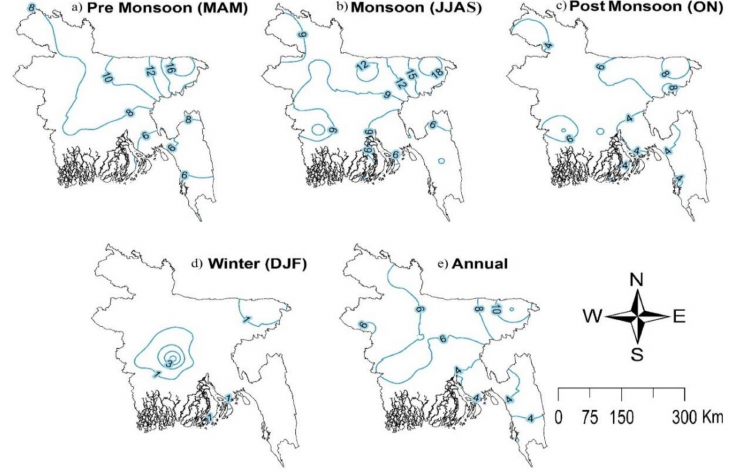
Figure 6. Spatial distribution of TS days ( a ) premonsoon (March–May (MAM)); ( b ) monsoon (June–September (JJAS)); ( c ) postmonsoon (October–November (ON)); ( d ) winter (December–February(DJF)); ( e ) annual in the ENSO years.